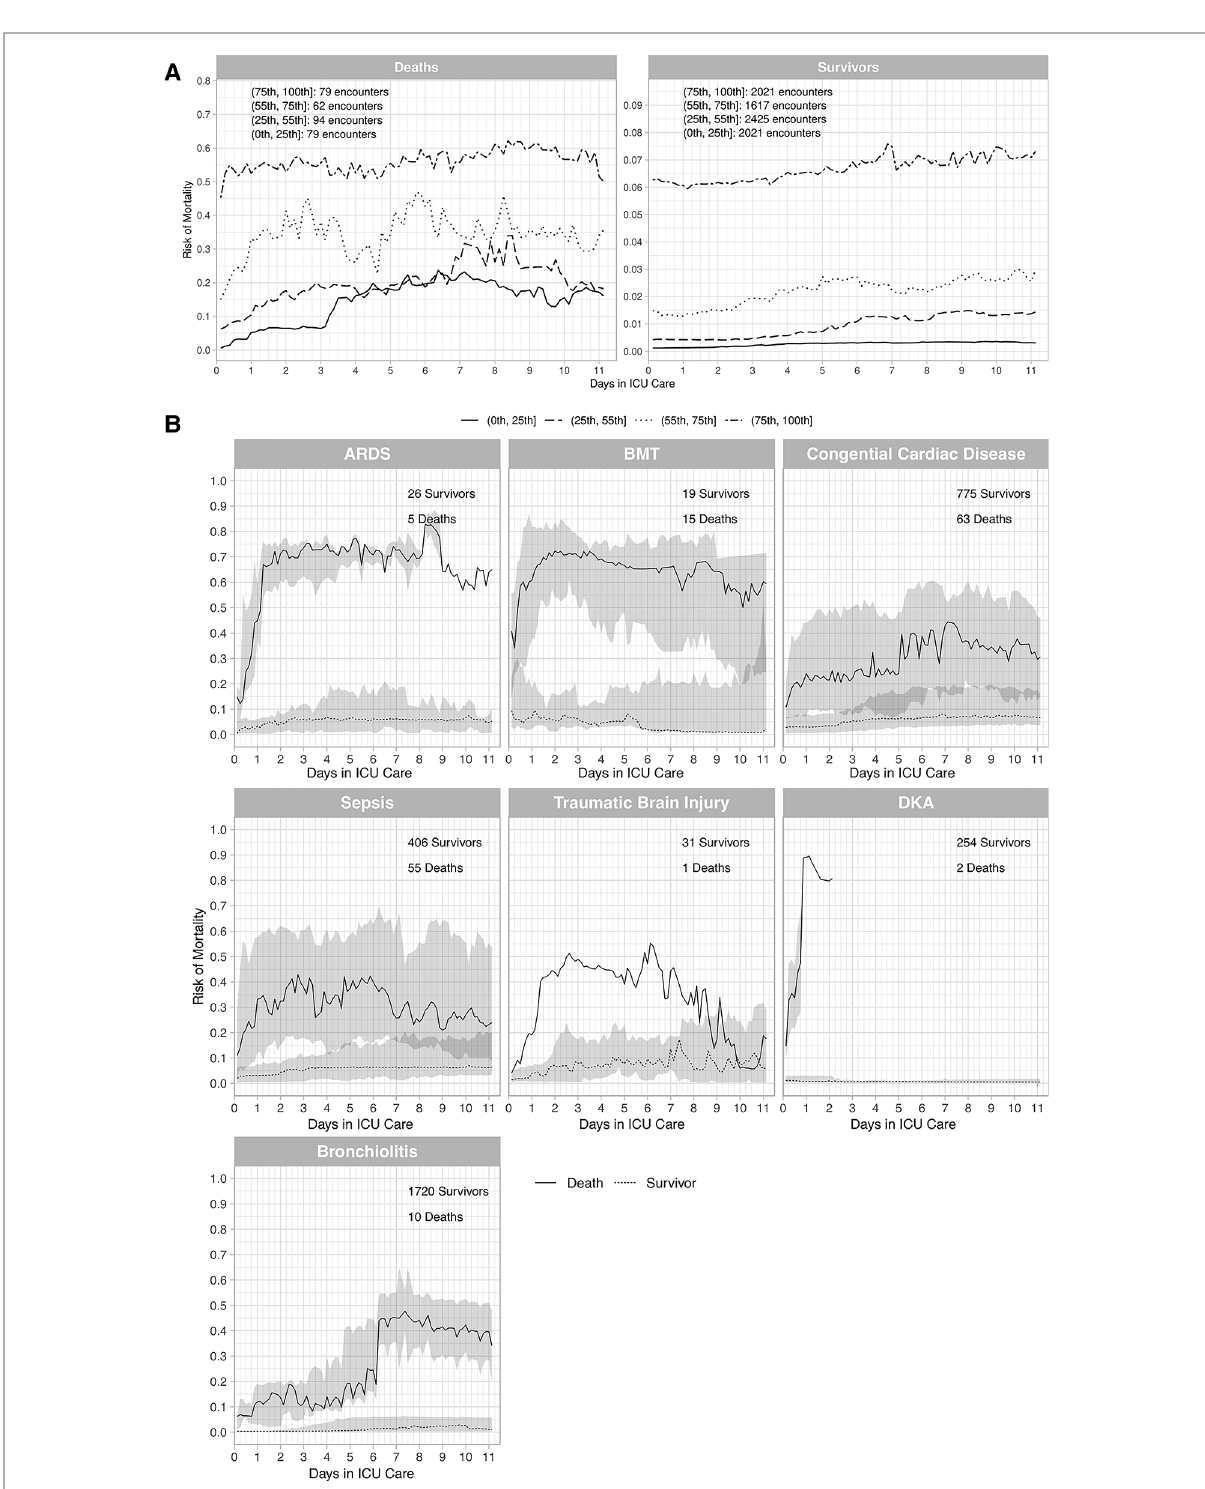
FIGURE 3 Trajectories for deaths and survivors by risk quartiles (A), and trajectories for deaths and survivors by diagnostic groups (B). (A) Death and survivor risk trajectories. Risk was computed with the Criticality Index-Mortality (CI-M). Median risk for each quartile for survivors and deaths used CI-M predictions. Patients were strati fi ed using the fi rst risk prediction at 3 h. The shaded areas are 95% con fi dence intervals (CIs). The trajectories were constructed from the total sample with 314 deaths and 8,087 survivors. (B) Death and survivor risk trajectories for different conditions. Risk was computed with the CI-M predictions and displayed for deaths and survivors. The numbers of survivors and deaths are shown in each panel. ARDS=Acute Respiratory Distress Syndrome (ARDS), BMT=Bone Marrow Transplants, DKA=Diabetic Ketoacidosis